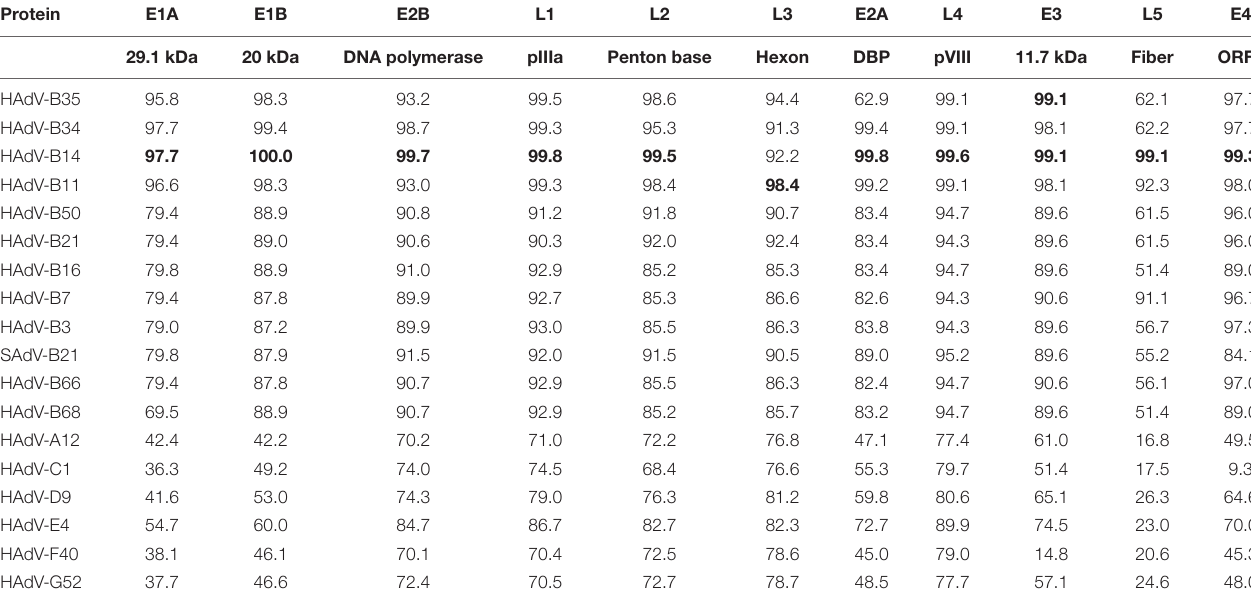
The proteins above span the whole genome. The highest values from each selected protein are in bold. TABLE 4 | Nucleotide substitution rate and selection pressures for the HAdV-55 major capsid protein genes.